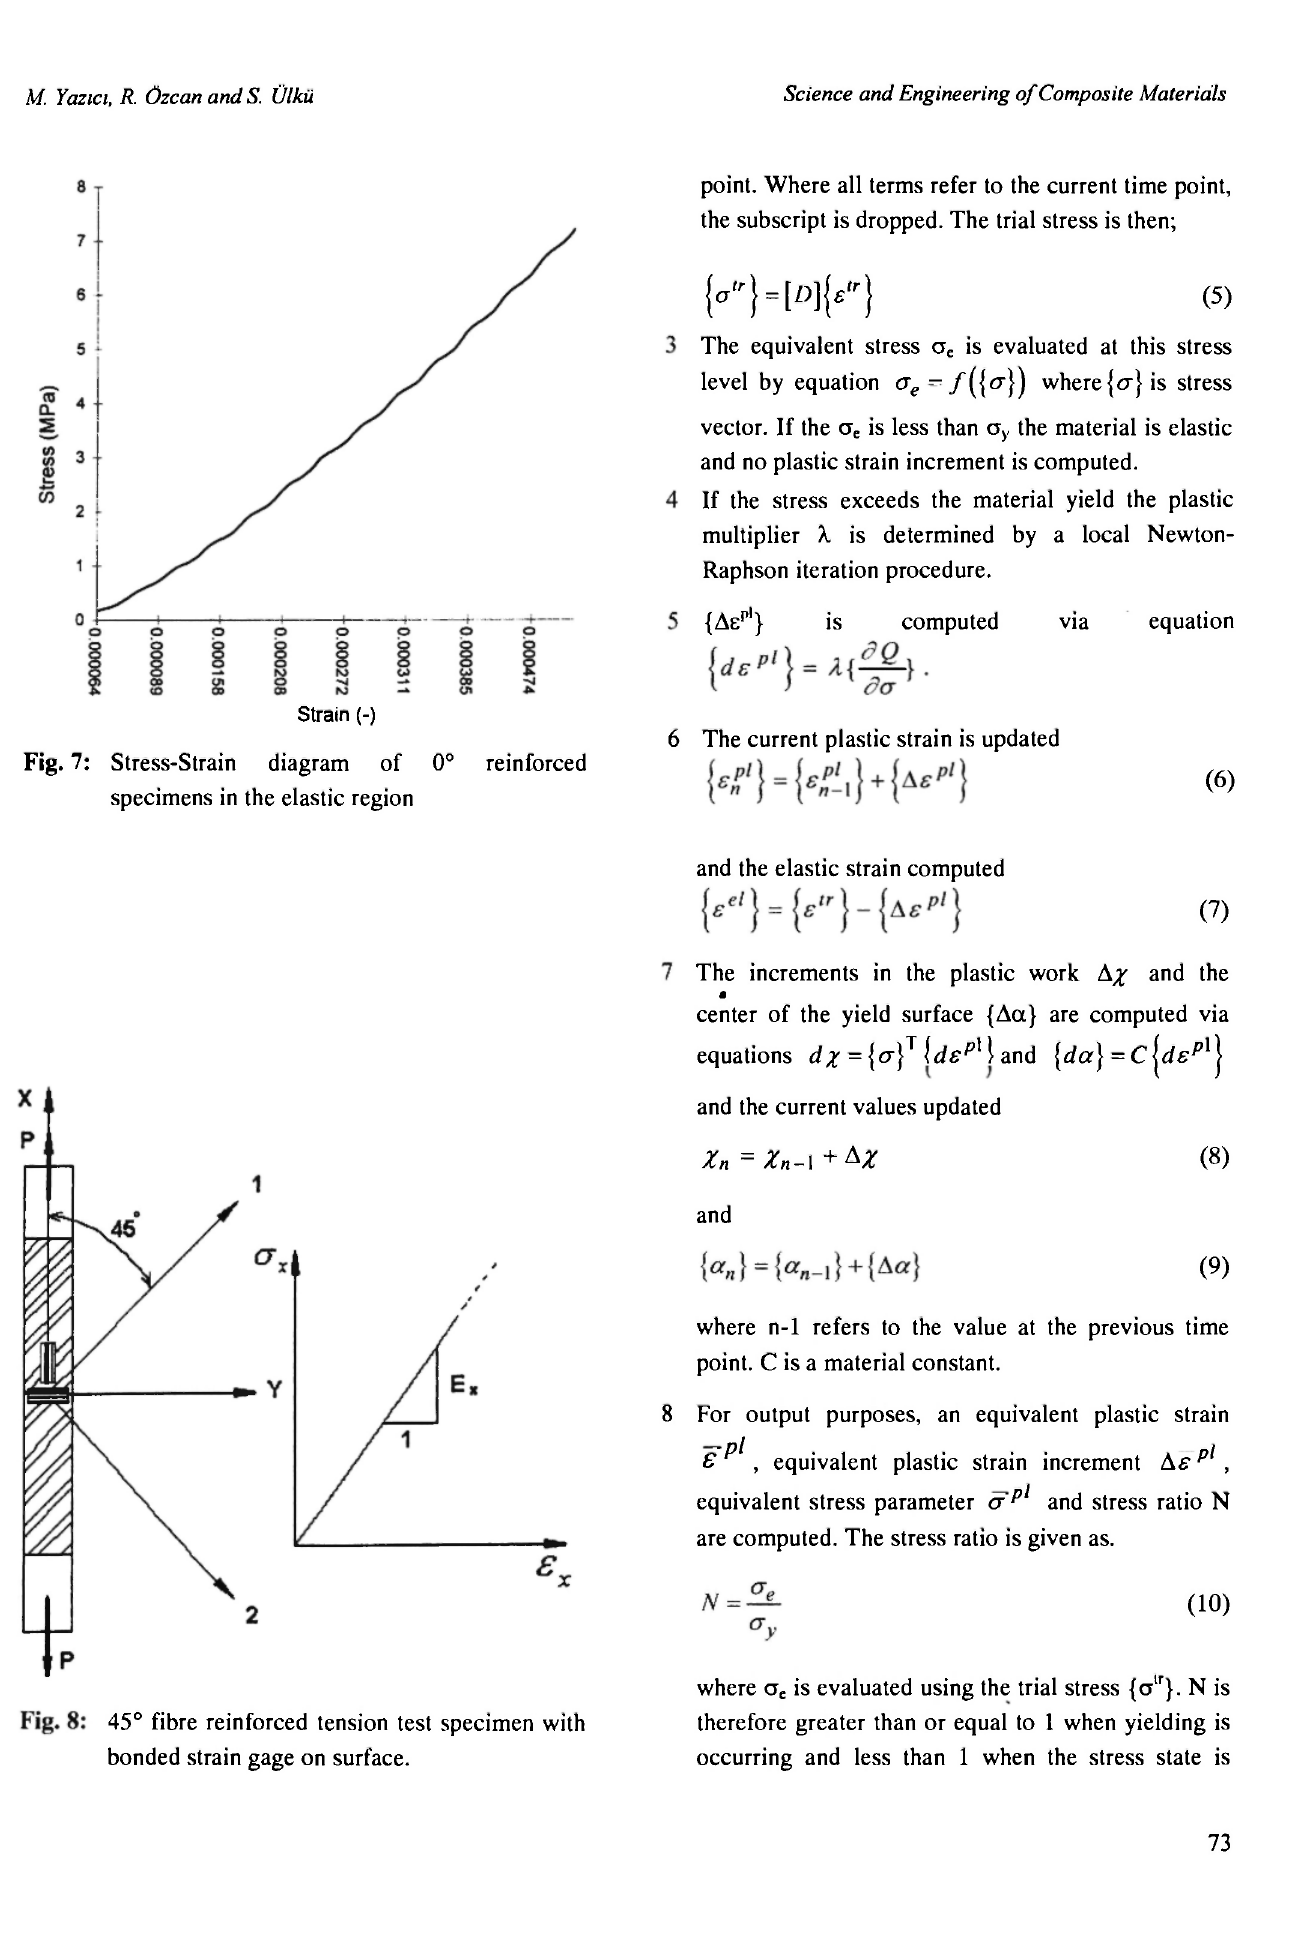
45° fibre reinforced tension test specimen with bonded strain gage on